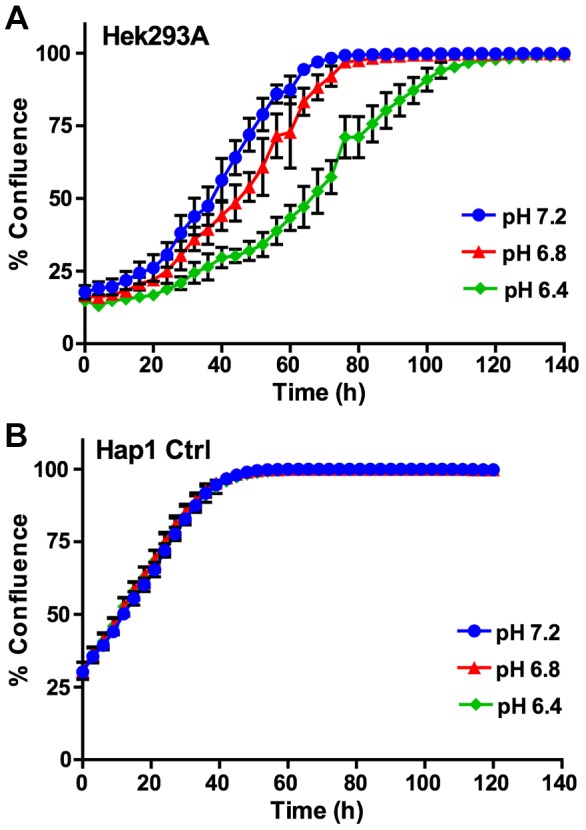
Growth of HEK293 cells is sensitive to acid stress whereas Hap1 cell growth is not over the pH range 6.4-7.2. HEK293A cells (A) and Hap1 control cells (B) were plated in 96-well plates at a starting density of 10,000 cells/well. After allowing cells to adhere to the plate for 2 h, cells were put into growth media buffered at pH 7.2, 6.8 or 6.4. Cells were then monitored for confluence in an IncuCyte imager over the timescale shown. Results from six replicate wells are shown. Error bars indicate standard deviation.